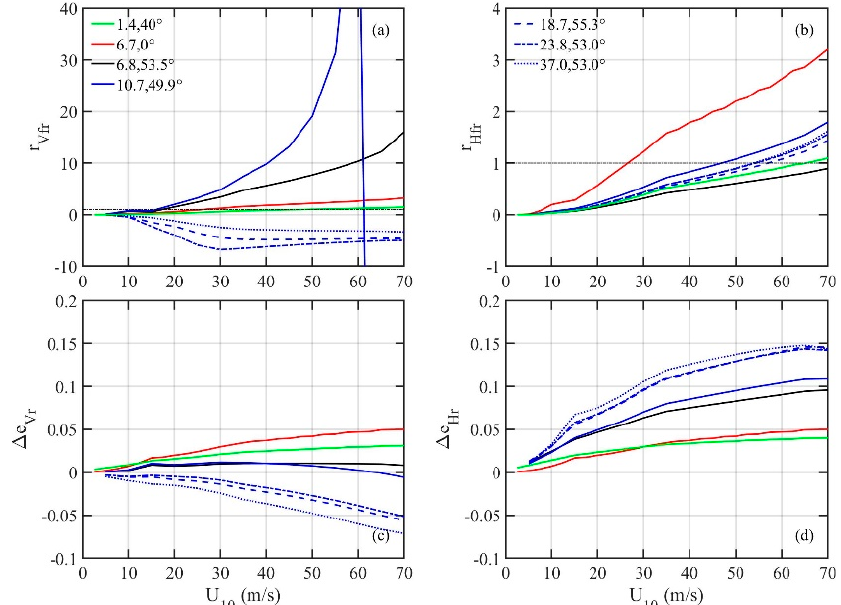
Figure 4. Foam-to-roughness ratio r pfr : ( a ) vertical polarization, ( b ) horizontal polarization. Roughness component of excess emissivity Δ e pr : ( c ) vertical polarization, ( d ) horizontal polarization.